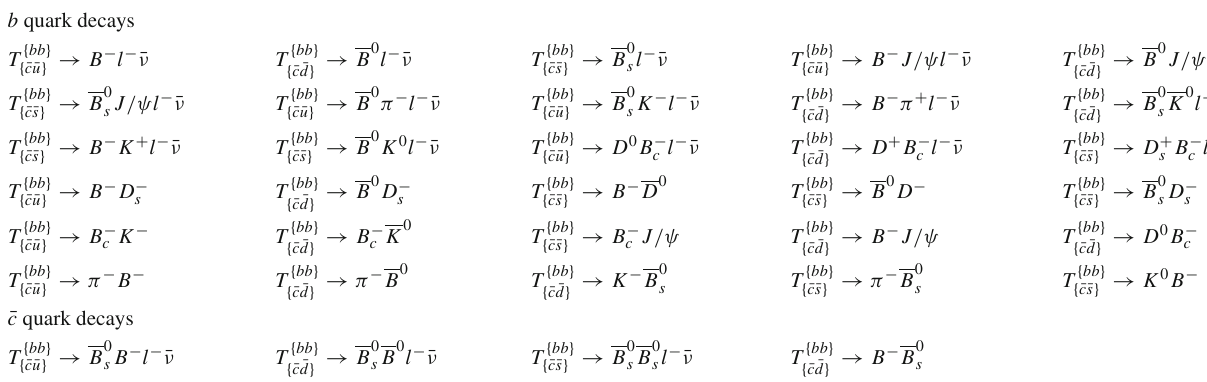
Table 6 Cabibbo allowed b ¯ cb ¯ q decays b quark